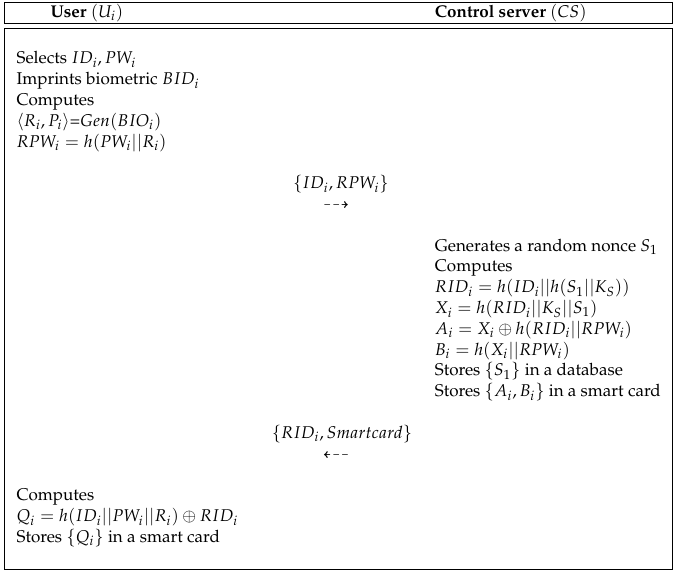
Figure 5. User registration process of the proposed scheme.